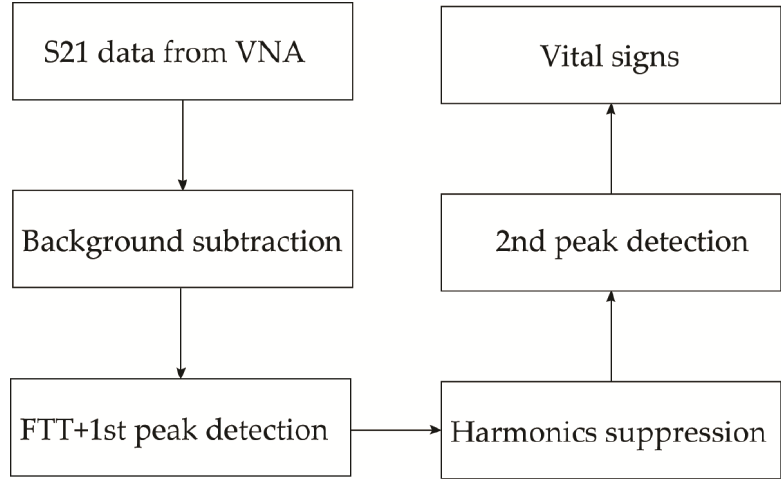
Figure 22. Algorithm used to process the experimental data.